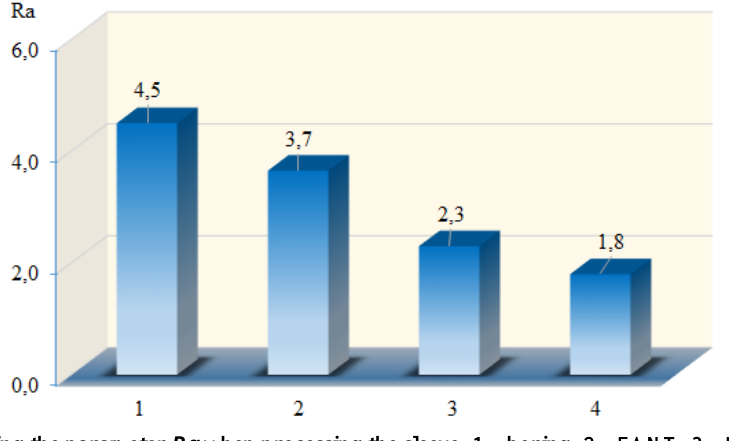
Fig. 3. Changing the parameter Ra when processing the sleeve: 1 – boring; 2 – FANT; 3 – DB with one deforming element; 4 – DB by two deforming